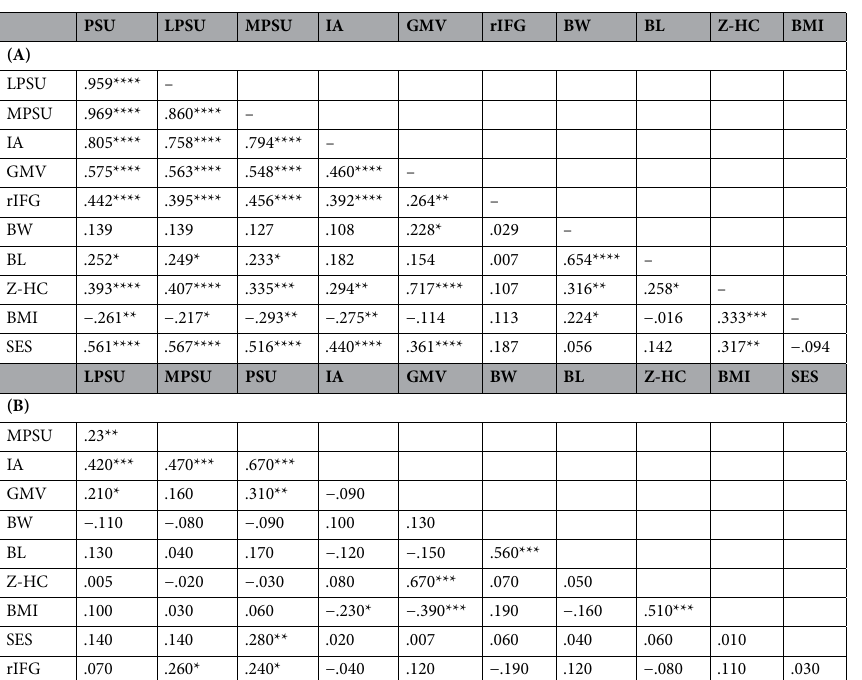
Table 5. Pearson correlation coefficients (A) and partial correlation coefficients (B) matrices between the University Selection Tests scores and most significant parameters . PSU: University Selection Test;